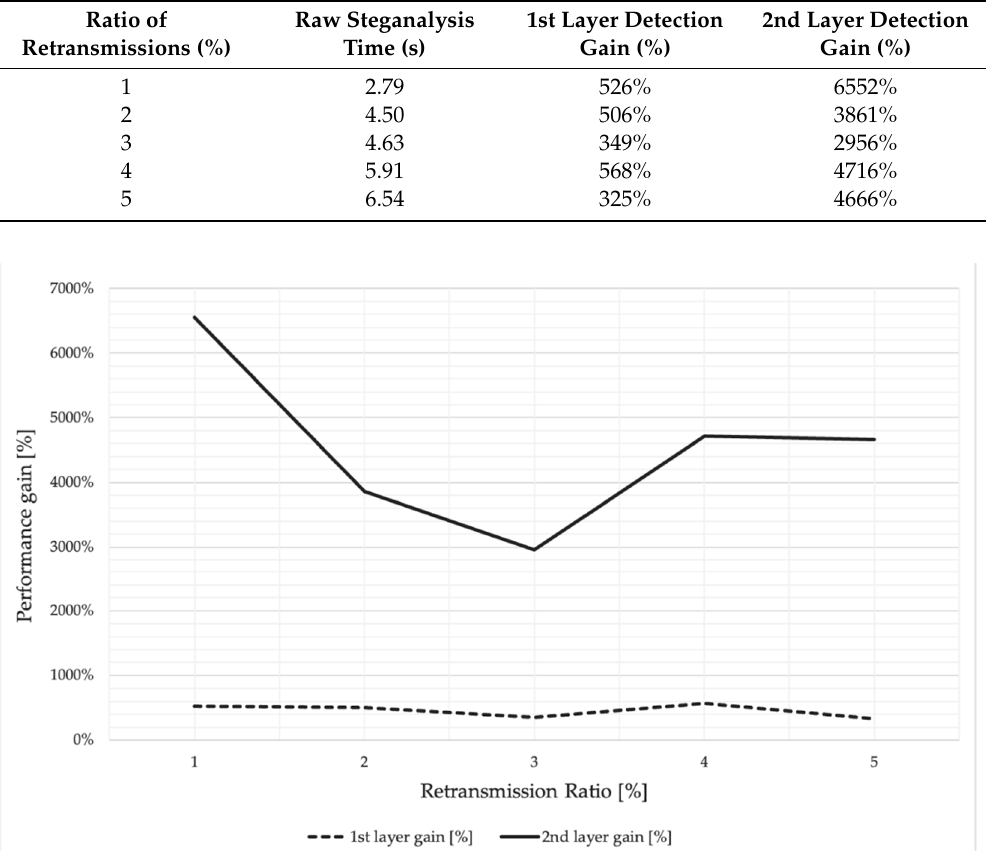
Table 3. Steganalysis performance gain.